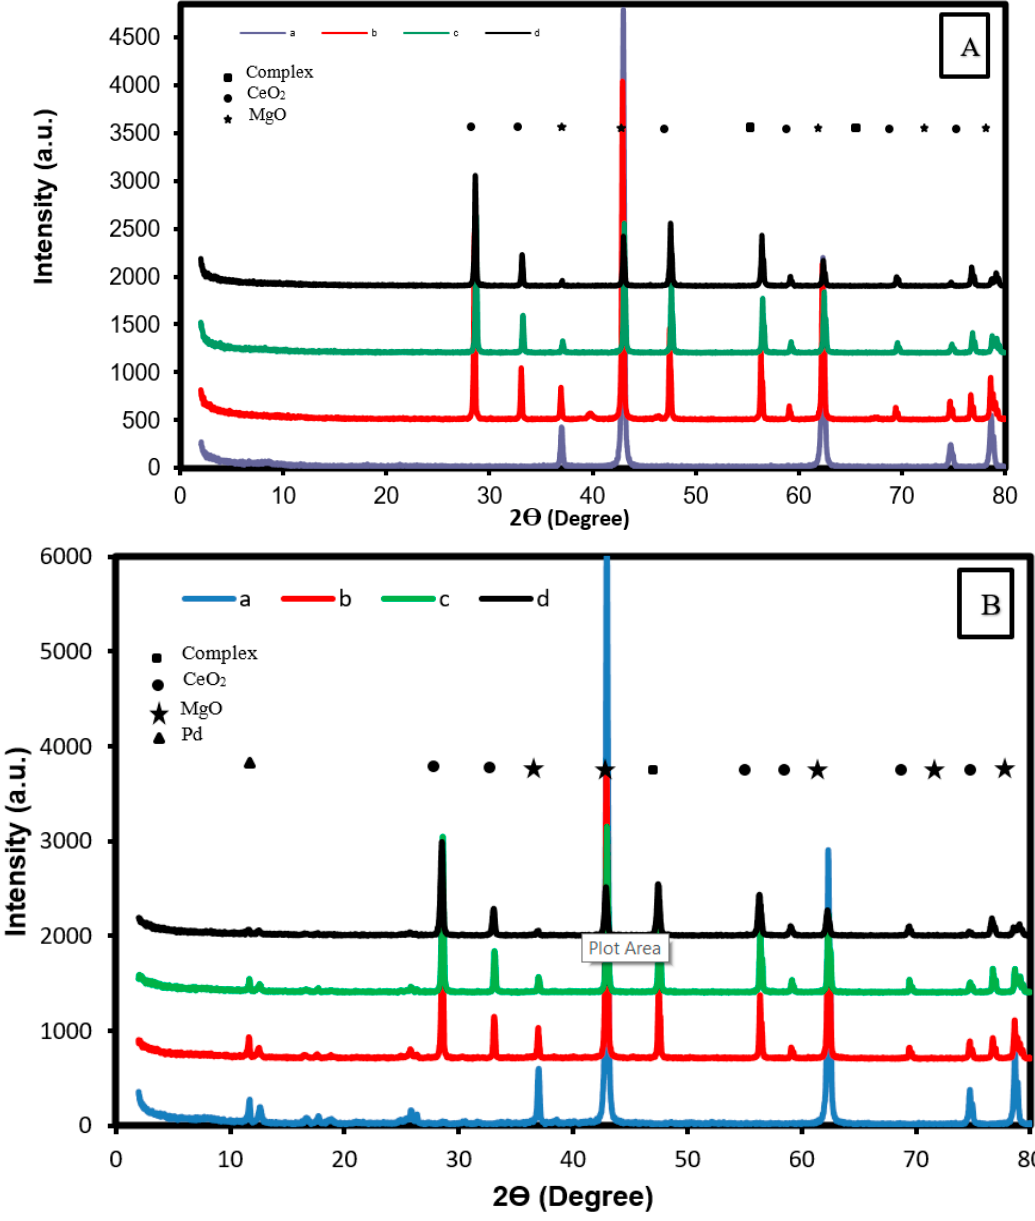
Figure 1. XRD patterns of the ( A ) Ni / Mg 1 − x Ce 4 + x O and ( B ) Ni,Pd,Pt / Mg 1 − x Ce 4 + x O catalysts, were (x = a (0.00), b (0.03), c (0.07), and d (0.15)).